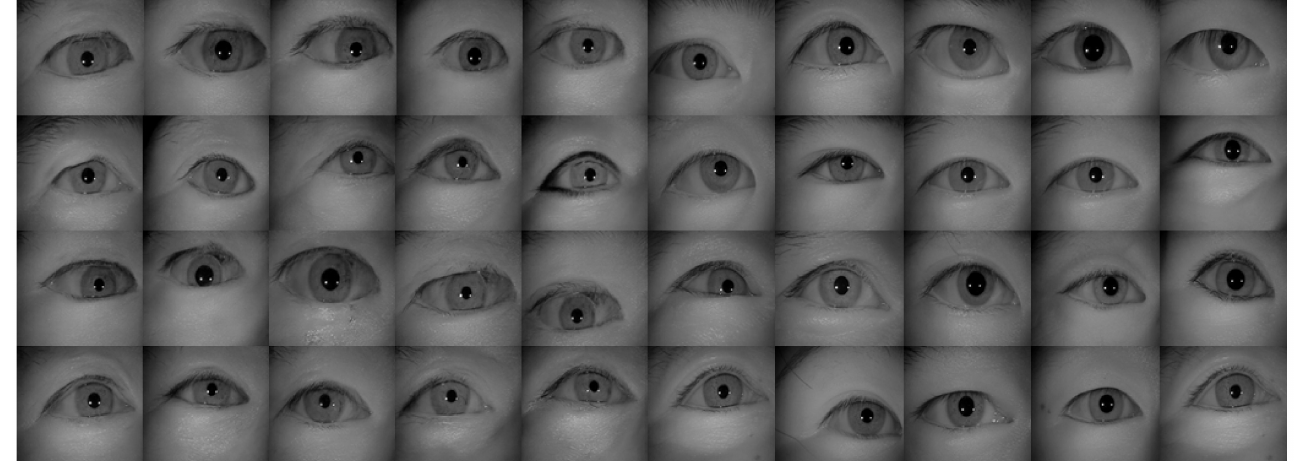
Figure 13. The examples of generated images (trained with CASIA-Iris-Thousands, without glasses) using the proposed iris image generation network.